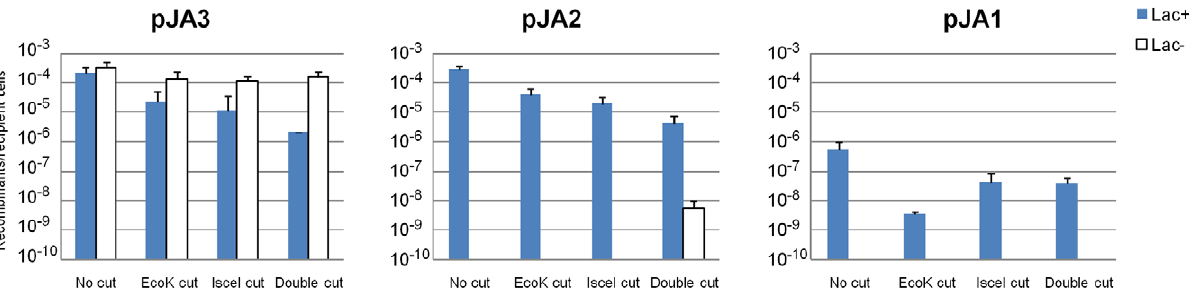
Figure 4. Efficiency of post-conjugative recombination with plasmids pJA3, pJA2 and pJA1. The Lac + (blue bars) and Lac 2 (white bars, when present) Cm R ex-conjugants reported to the viable recipient cells, are scored